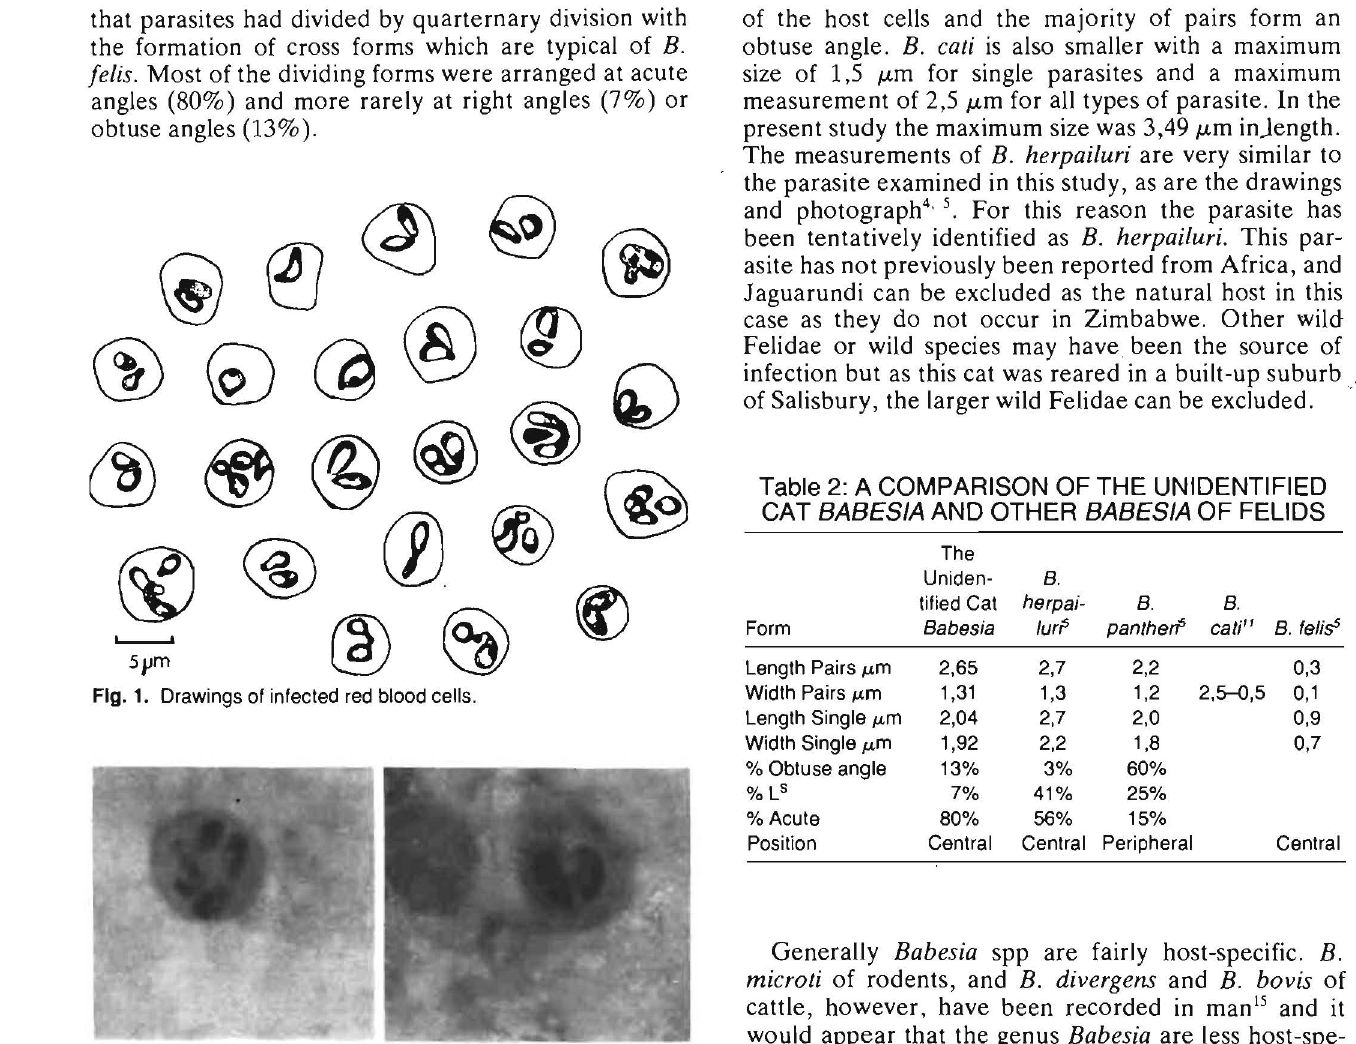
Fig. 2. Different forms of Babesia species from a cat.